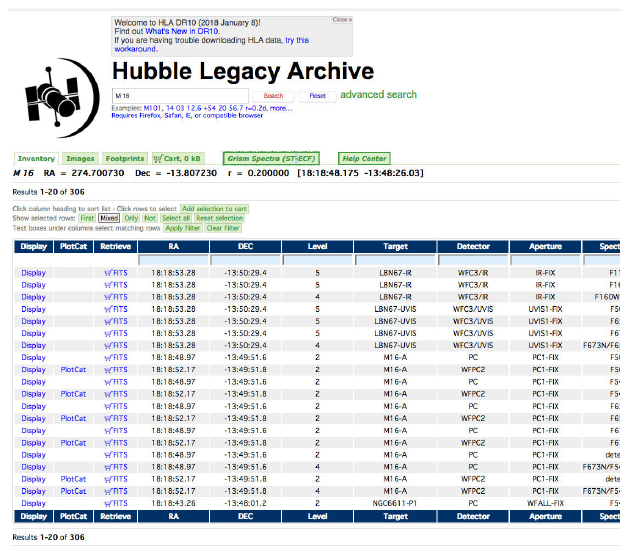
Fig. 34.— Search results from the Hubble Legacy Archive to scroll right to see the columns 13 and 14 we are in- terested in. In column 14, called “Dataset”, look for the data set names